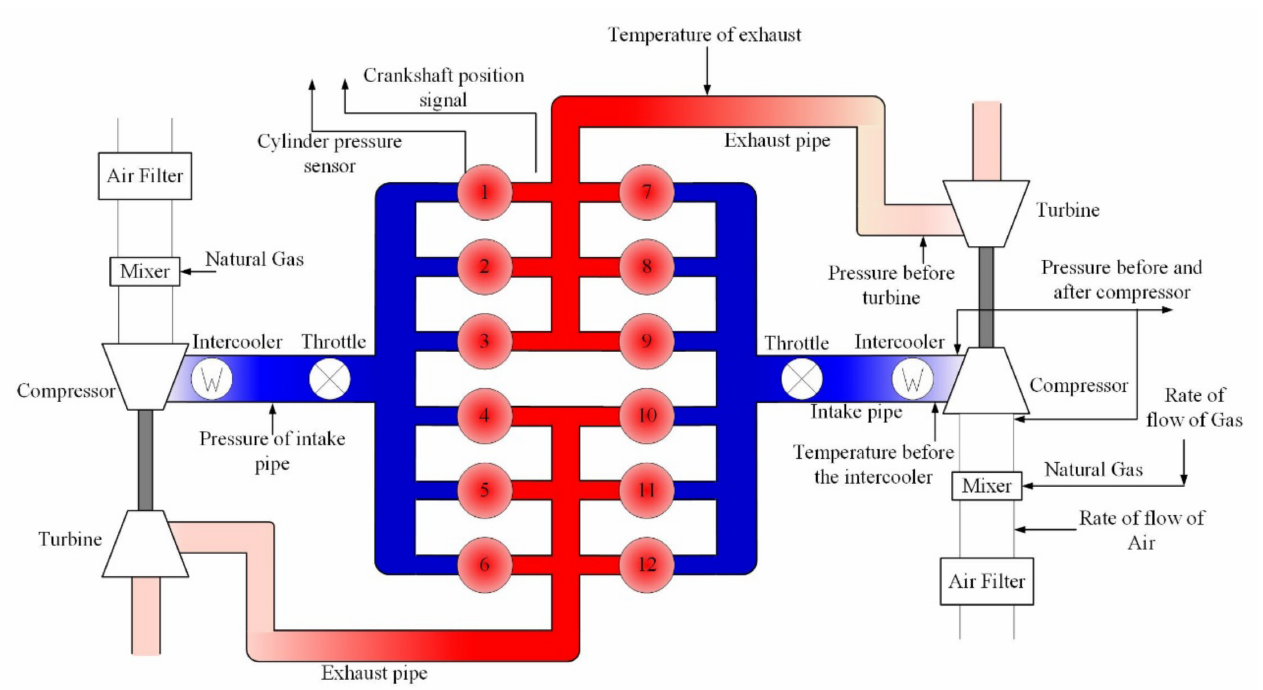
Figure 1. Schematic of the experimental